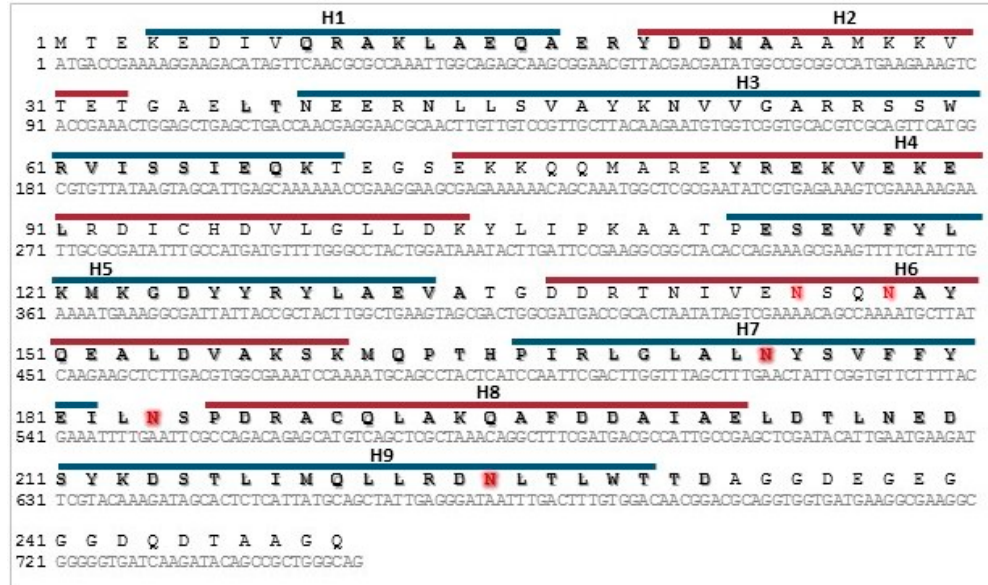
Figure 1. Schematic representation of cloned Tb14-3-3. Nucleotide and amino acid sequences are presented. Conserved regions of the protein chain are bolded (according to McGowan et al. [22] ). Nine α -helices are marked with upper lines and numbered H1-H9. Potential N-glycosylation sites are highlighted in red.